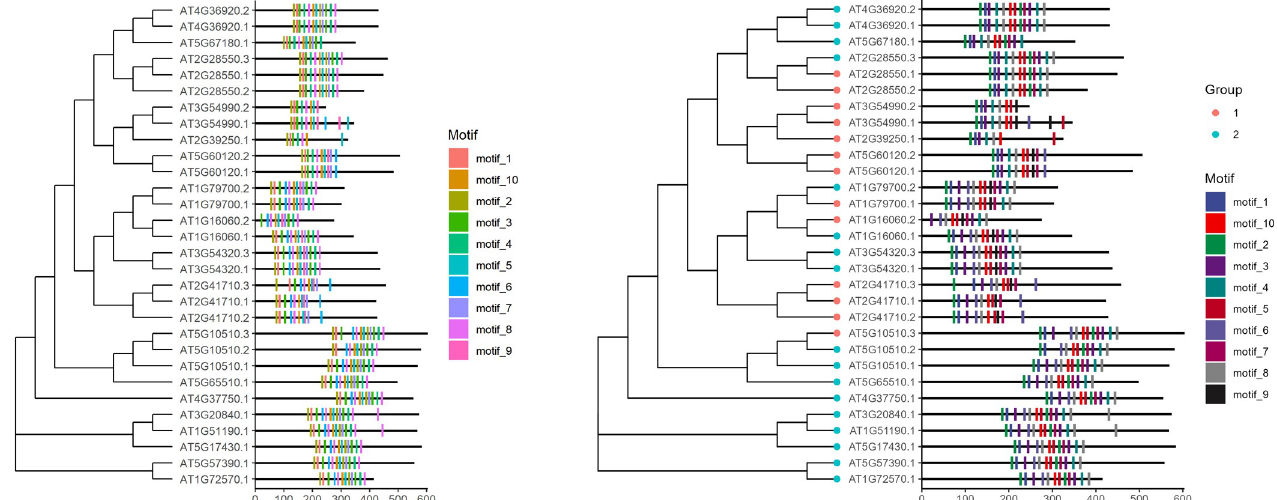
Fig 3. The location of motifs on the corresponding sequences (right panel) and the corresponding phylogenetic tree (left panel). The light blue and orange dots in Fig 3B represent the number of AP2/ERF domains in the corresponding sequences. motif_plot < - motifLocation(data = motif_extract, tree = treepath)